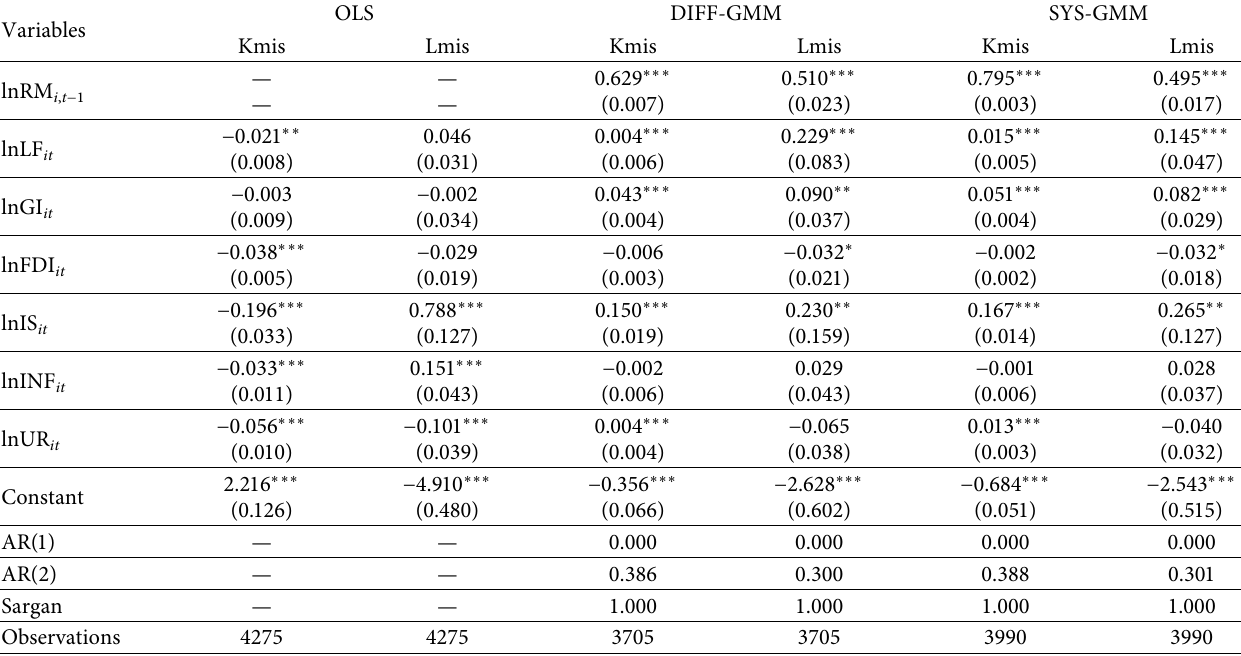
Table 3: Estimation results for the whole sample.